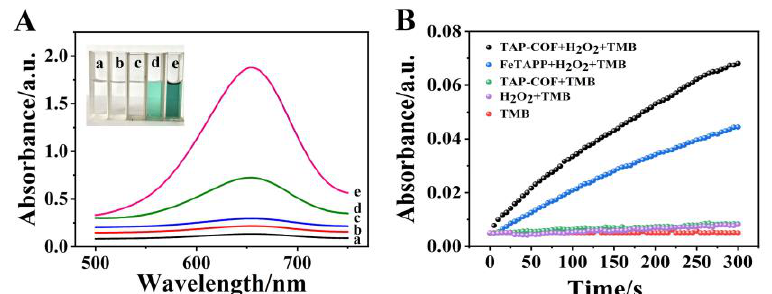
Figure 2. The absorbance changes of TMB, H 2 O 2 + TMB, TAP-COF + TMB, FeTAPP + H 2 O 2 + TMB, and TAP-COF + H 2 O 2 + TMB are illustrated in ( A ) UV – vis spectra and ( B ) the impact of time on and TAP-COF + H 2 O 2 + TMB are illustrated in ( A ) UV–vis spectra and ( B ) the impact of time on these changes. TMB reaction mixture ’ s color variations are seen in the inset. these changes. TMB reaction mixture’s color variations are seen in the